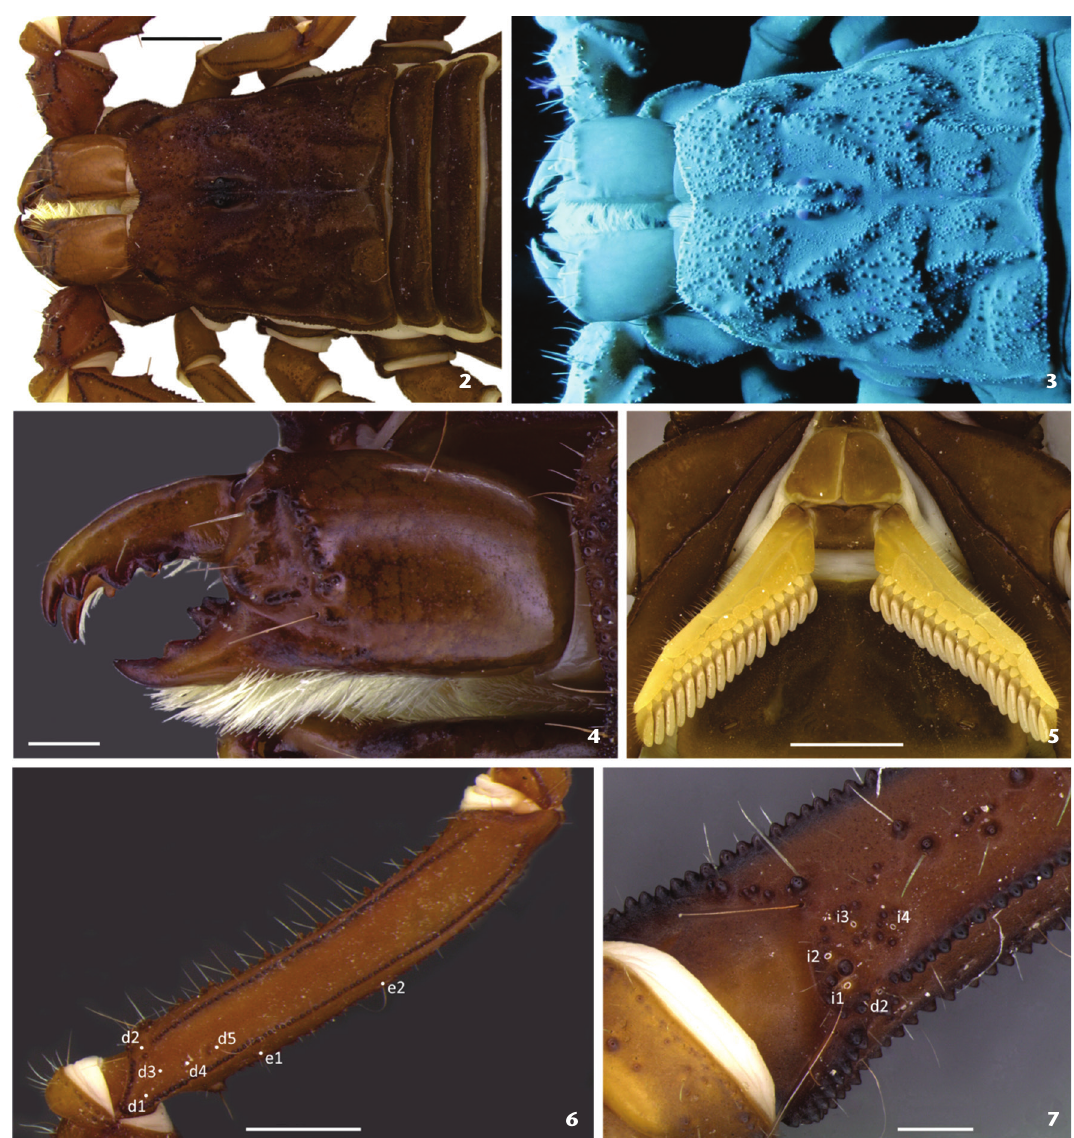
of fingers with conspicuous setae; fixed and movable fingers with slightly oblique rows of granules, presence of internal and external accessory granules as well as presence of internal and external supernumerary granules; three granules at distal area of movable fingers, do not count as a oblique row of